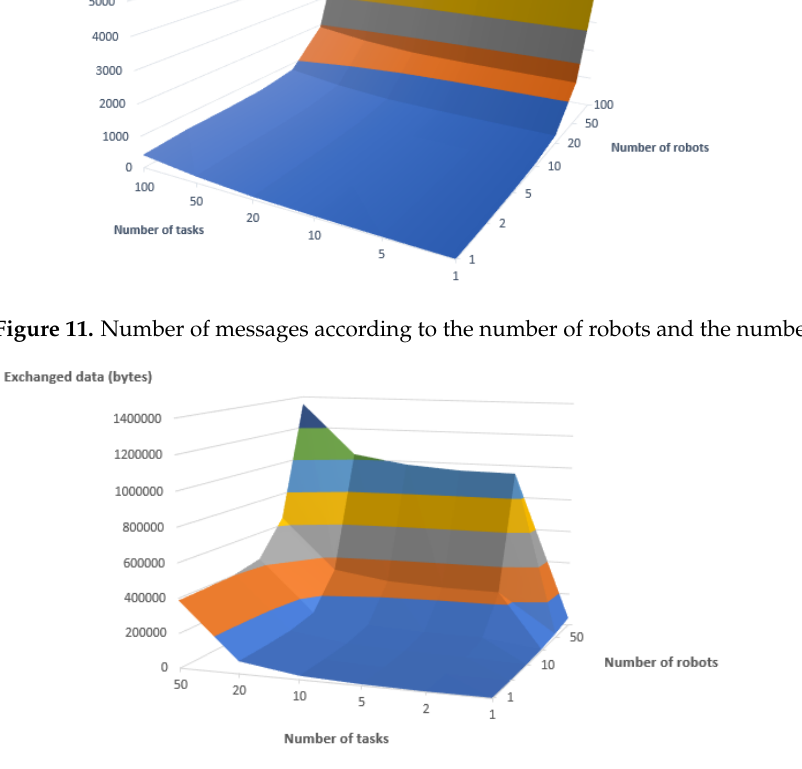
Figure 12. Exchanged data amount according to the number of robots and the number of tasks.